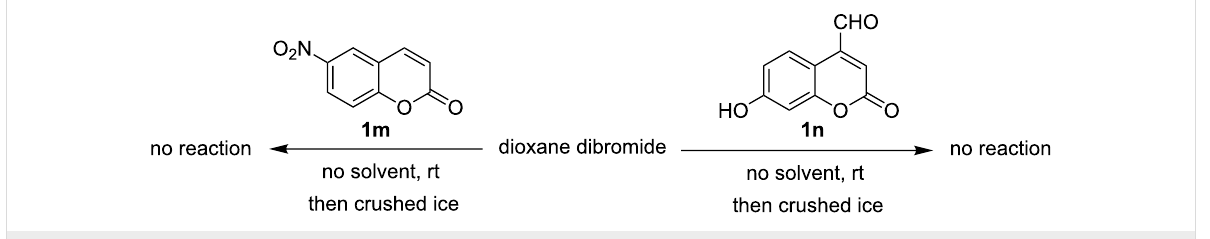
Scheme 2: Failure of DD to react with coumarins substituted with an electron-withdrawing